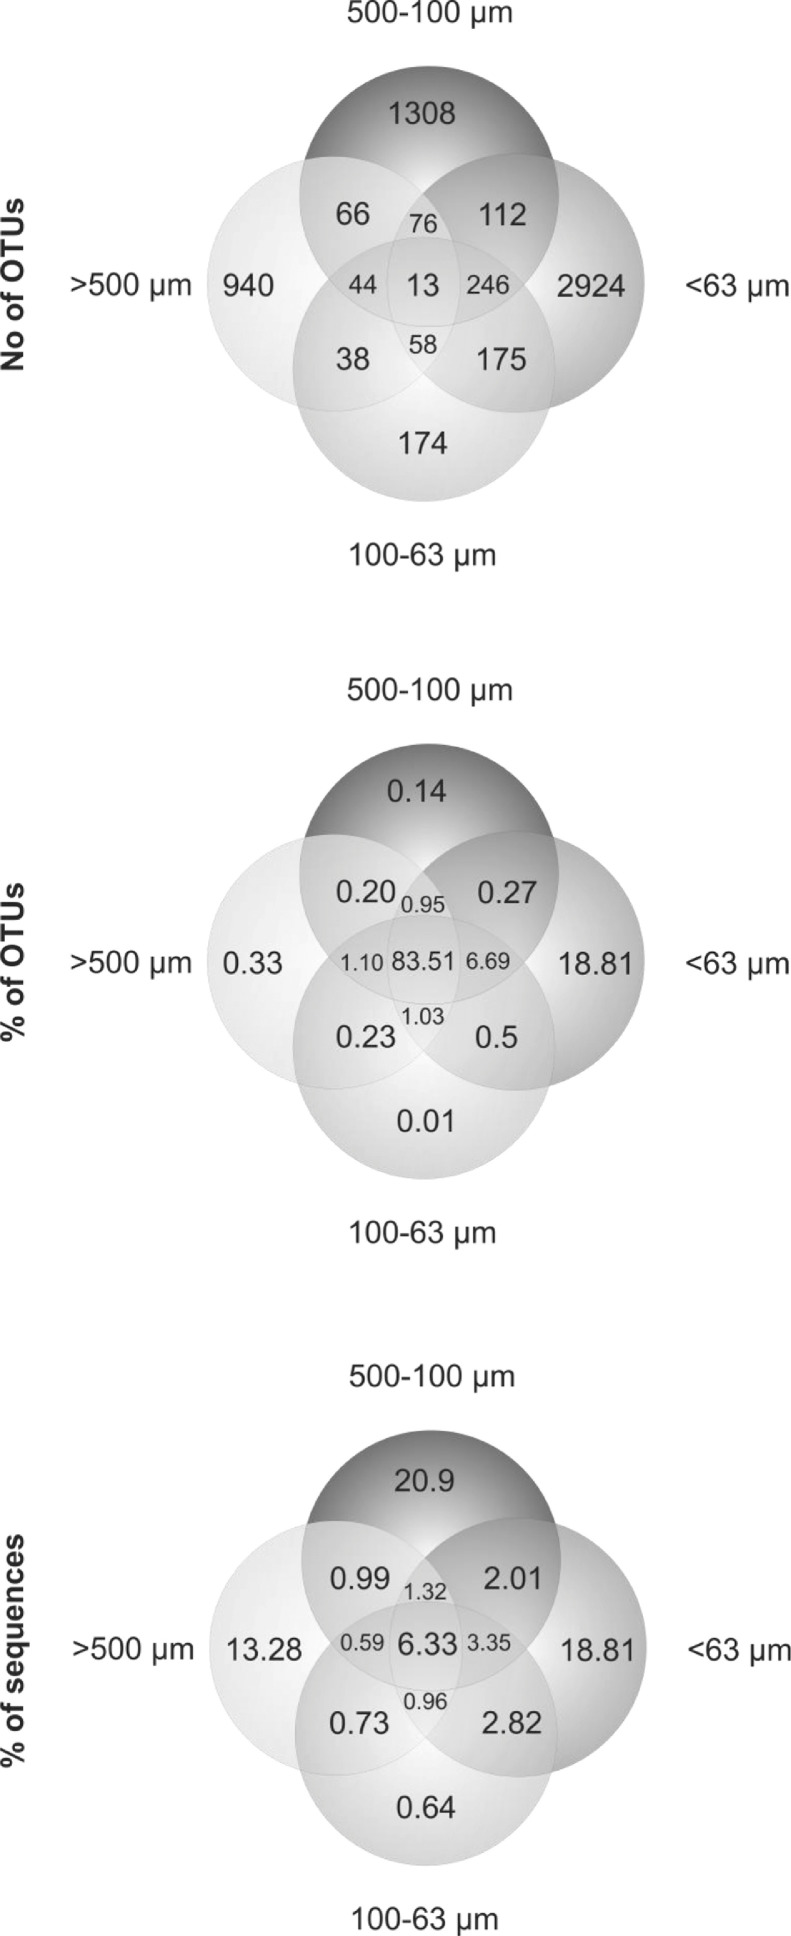
Venn diagrams of number of OTUs, percent [%] of OTUs, and percent [%] of sequences found in the studied sediment fractions (>500 µm, 500–100 µm, 100–63 µm, <63 µm).